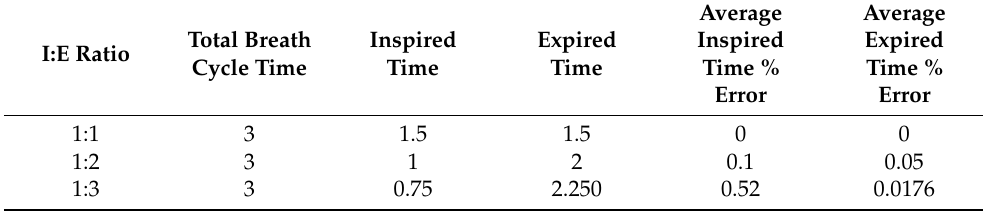
Table 4. Inspired-time and expired-time test results for BPM of 20.